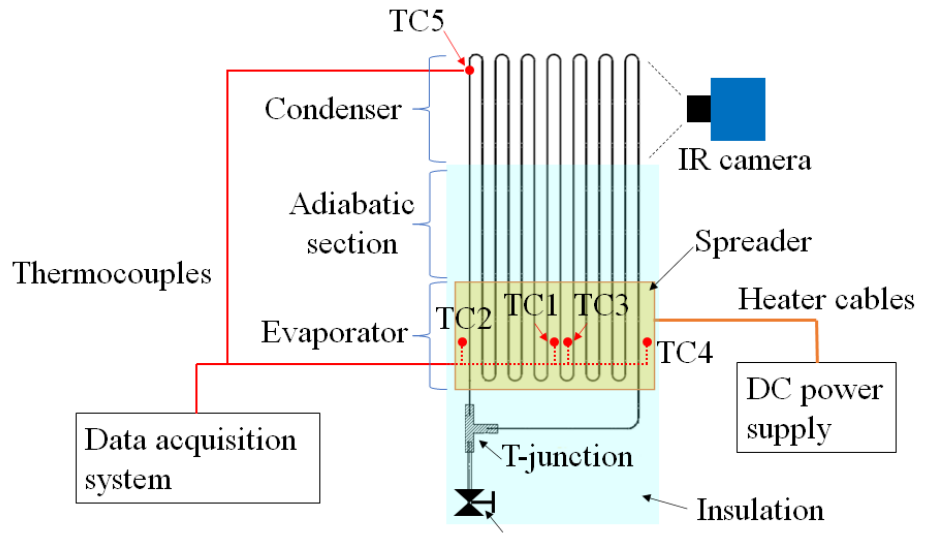
Figure 1. Experimental setup sketch.